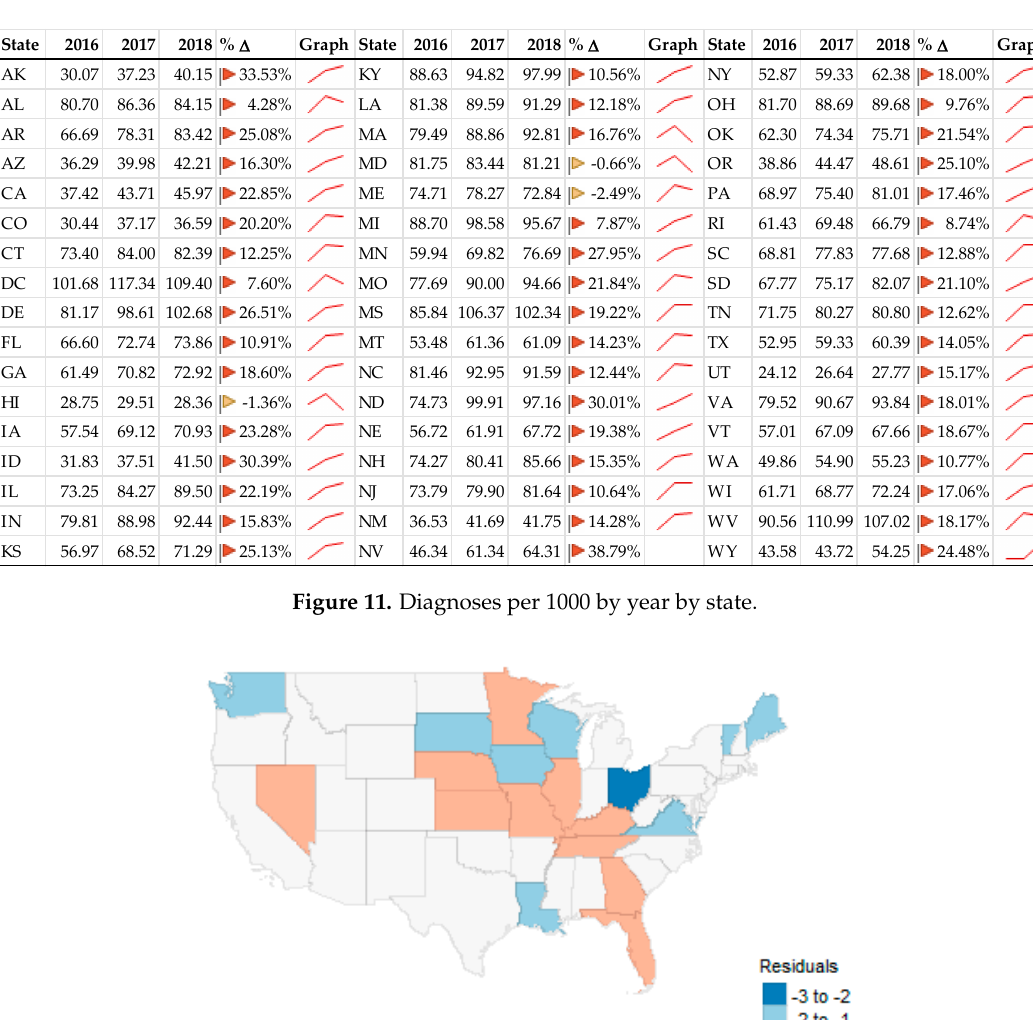
Figure 10. Admissions per 1000, 2016 through 2018.